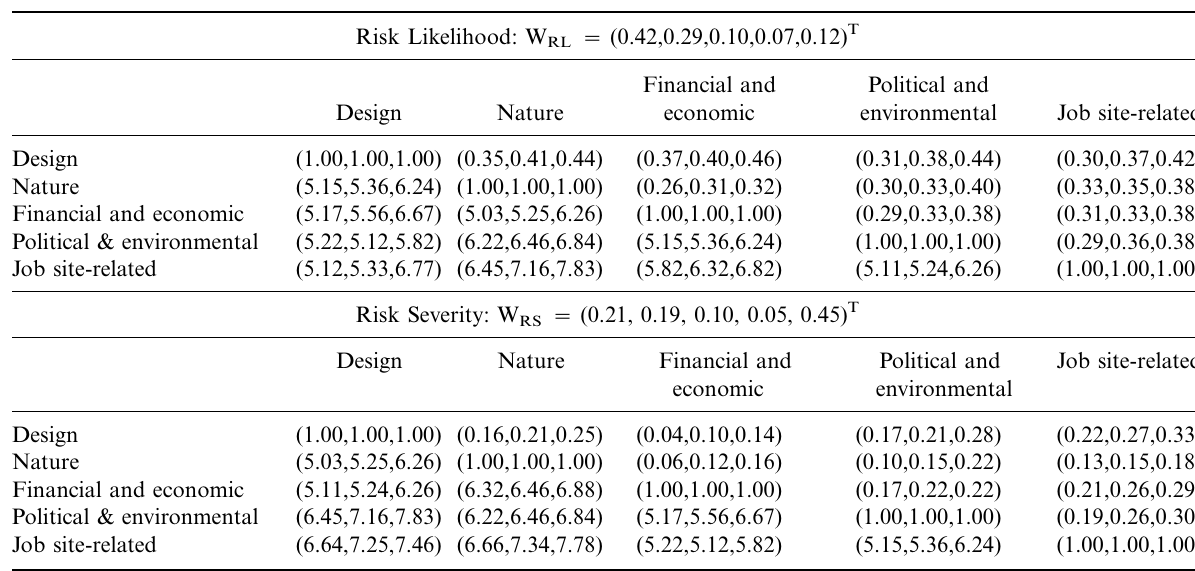
Table 9. (Level 2) Matrices of pairwise comparisons and respective normalized weigh vectors